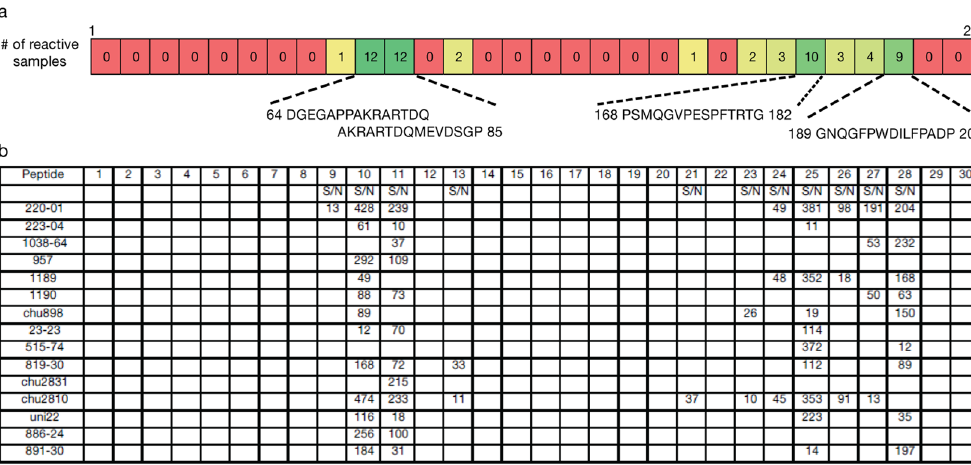
Table S3). The comparator assay detected 3 of 7 antibody only samples detected by the prototype assay. Of the remaining 4 non-confirmed samples, 3 were low S/CO reactive in the prototype assay (S/CO < 1.50). Identification of linear epitopes in HDV large antigen. Additionally, a peptide scan of the entire HDV large antigen open reading frame was designed to identify small linear epitopes. The study using the larger 7 pep- tides defined antigenic regions within amino acids 59–84 and 92–114. HDV RNA positive samples were tested with the scanning peptides in an indirect IgG assay (Fig. 5A). Two overlapping peptides (aa 64–85) showed reac- tivity with 14/15 samples tested (Fig. 5B); the sequence AKRARTDQ was common to both peptides and mapped to the original peptide 2 (Fig. 3). Additional linear epitopes were identified in regions (aa 168–182 and 189–203) that were not included in the original peptide design (Fig. 5A). The original peptide 4 detected several samples, but small peptides derived from the original peptide 4 were not reactive in the assay (Fig. 5A).